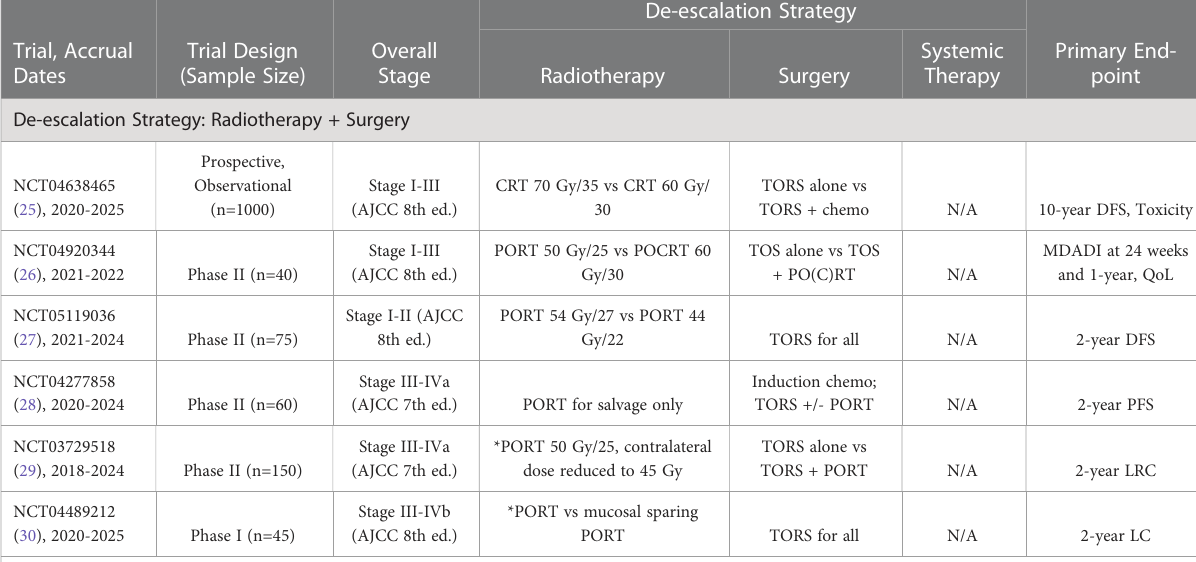
TABLE 3 Current trials examining radiotherapy de-escalation and surgery for treatment of HPV-associated OPSCC.